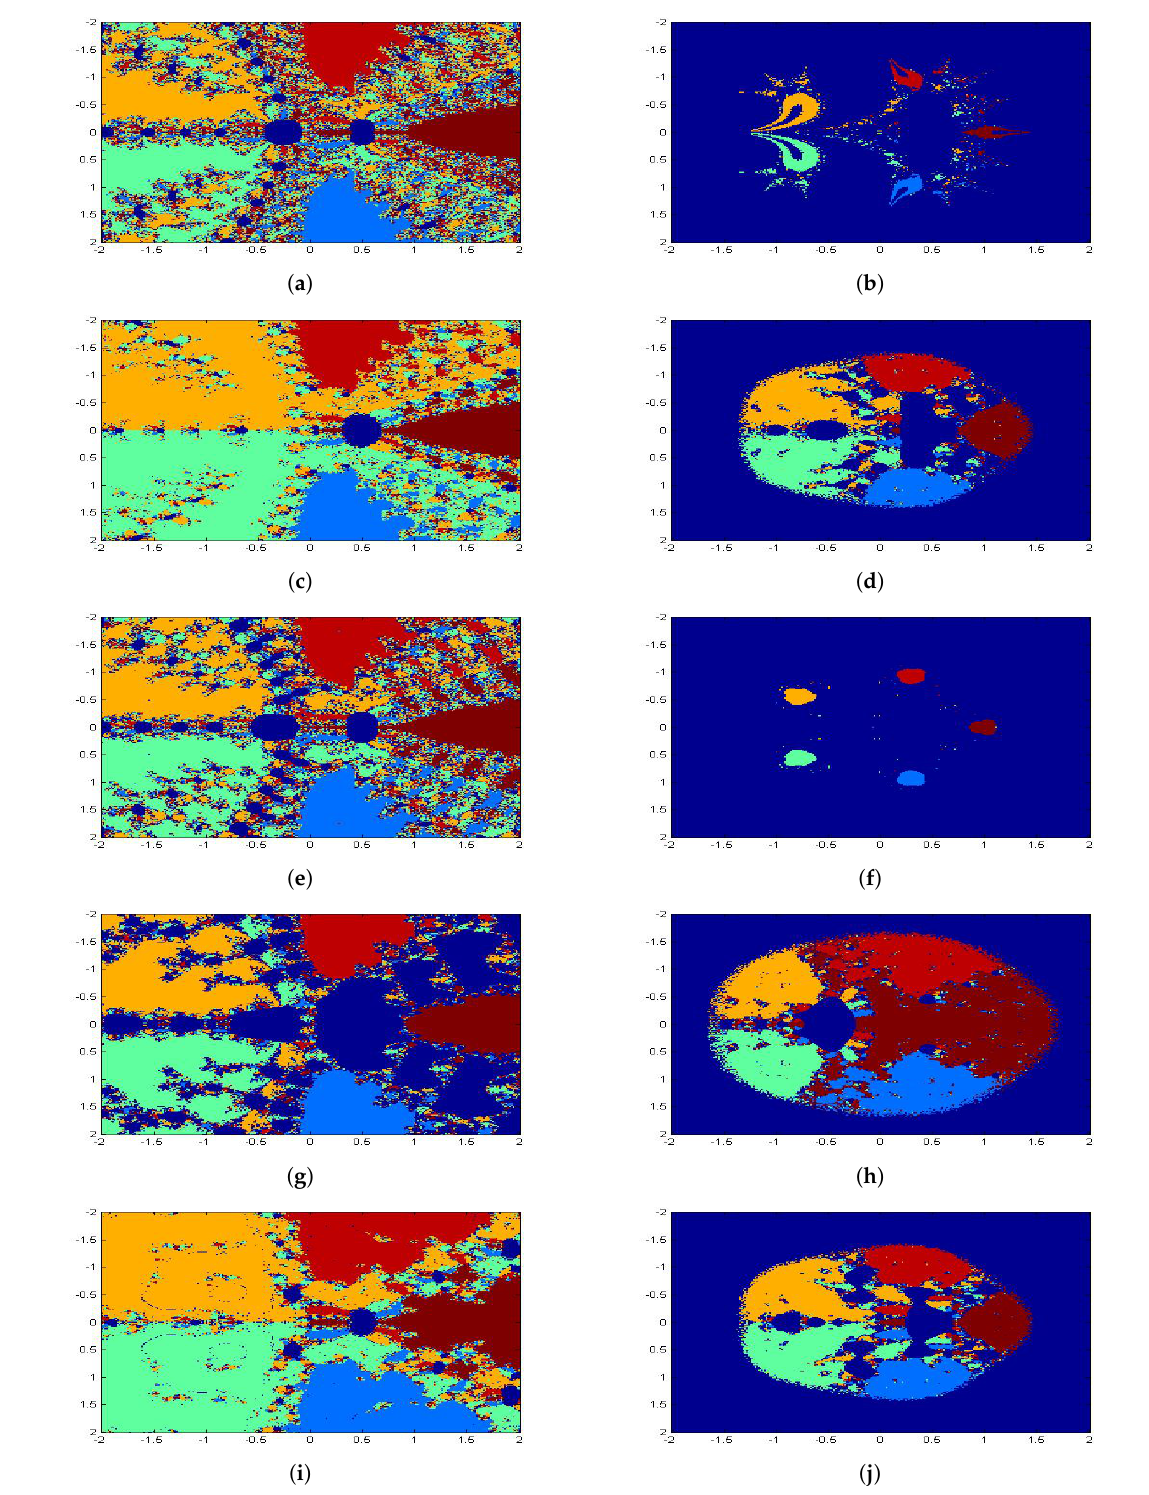
Figure 5. Polynomiographs of p 4 ( z ) : ( a ) KTM 4; ( b ) AKKB 4; ( c ) ZLM 4; ( d ) PM 4; ( e ) AKKB 8; ( f ) KBK 8; ( g ) SM 8; ( h ) PM 8; ( i ) ZLM 16; and ( j ) PM